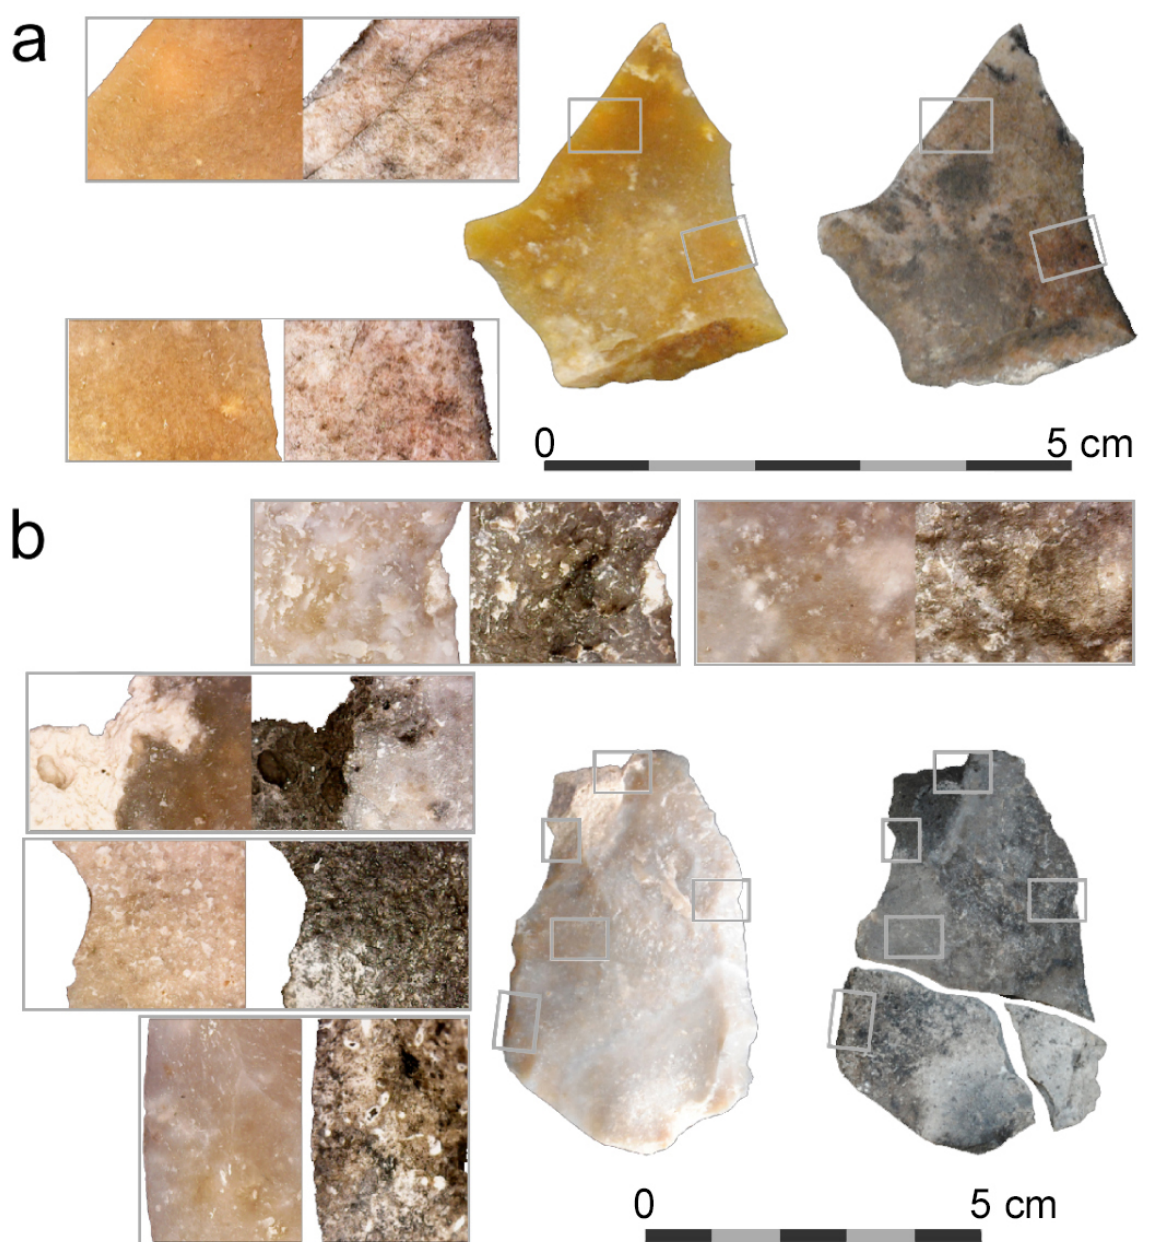
Figure 11. Macro and detail photos of blanks altered by surface contact with fire. a) Small Bergerac flint blank presenting SAL 4 and development of internal cracking; b) SMM flint blank presenting SAL 4 and marginal and transversal fractures. In the case of SMM blank cortex and sandy surface tend to be carbonized while more siliceous flint-like surface tends to high dehydration, presenting